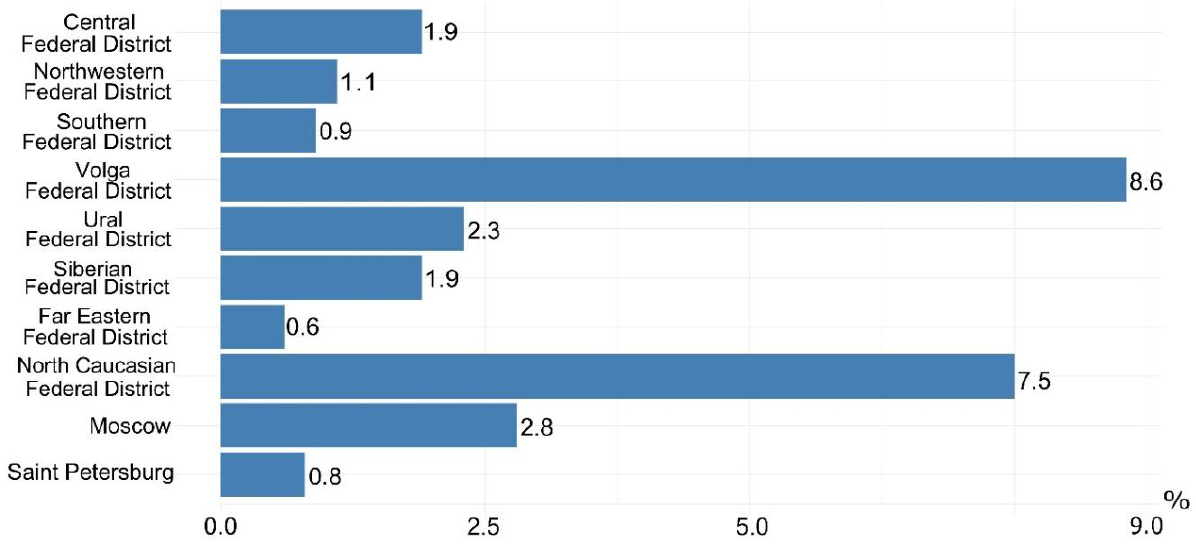
Figure 1. Allelic frequency of the E92K variant in the federal districts of the Russian Federation [5]. In the Turkish Cystic Fibrosis Patient group, the E92K variant frequency in 2020 was